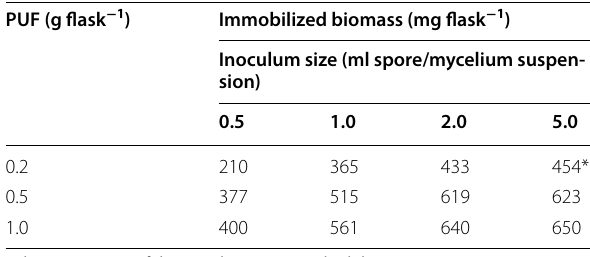
Values are means of three replicates * Standard errors are smaller than 5% and are not shown